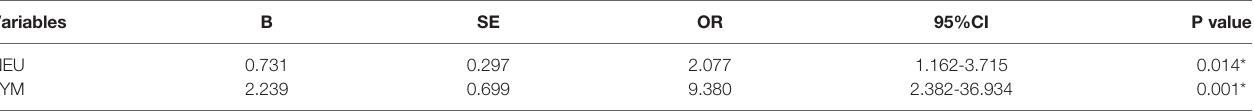
TABLE 2 | Multivariate logistic regression analysis of patients with asymptomatic COVID-19 and patients with moderate COVID-19. Variables B